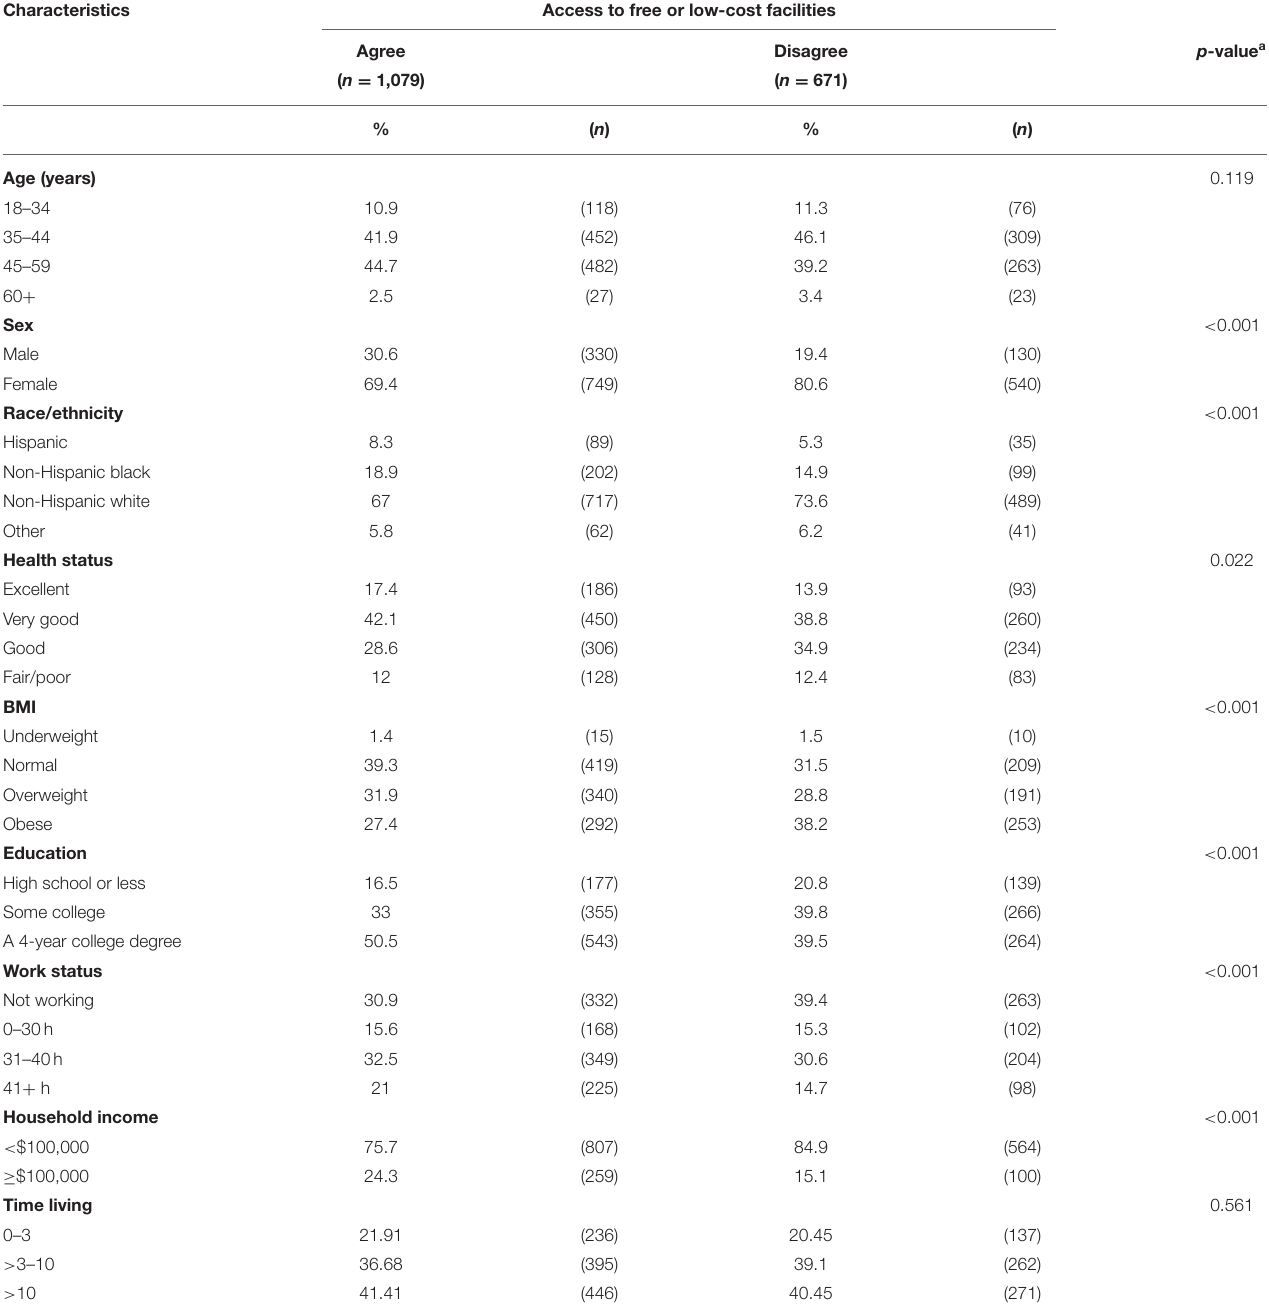
TABLE 1 | Characteristics distribution of the 2017 FLASHE participants with and without access to free or low-cost recreational facilities. Characteristics Access to free or low-cost